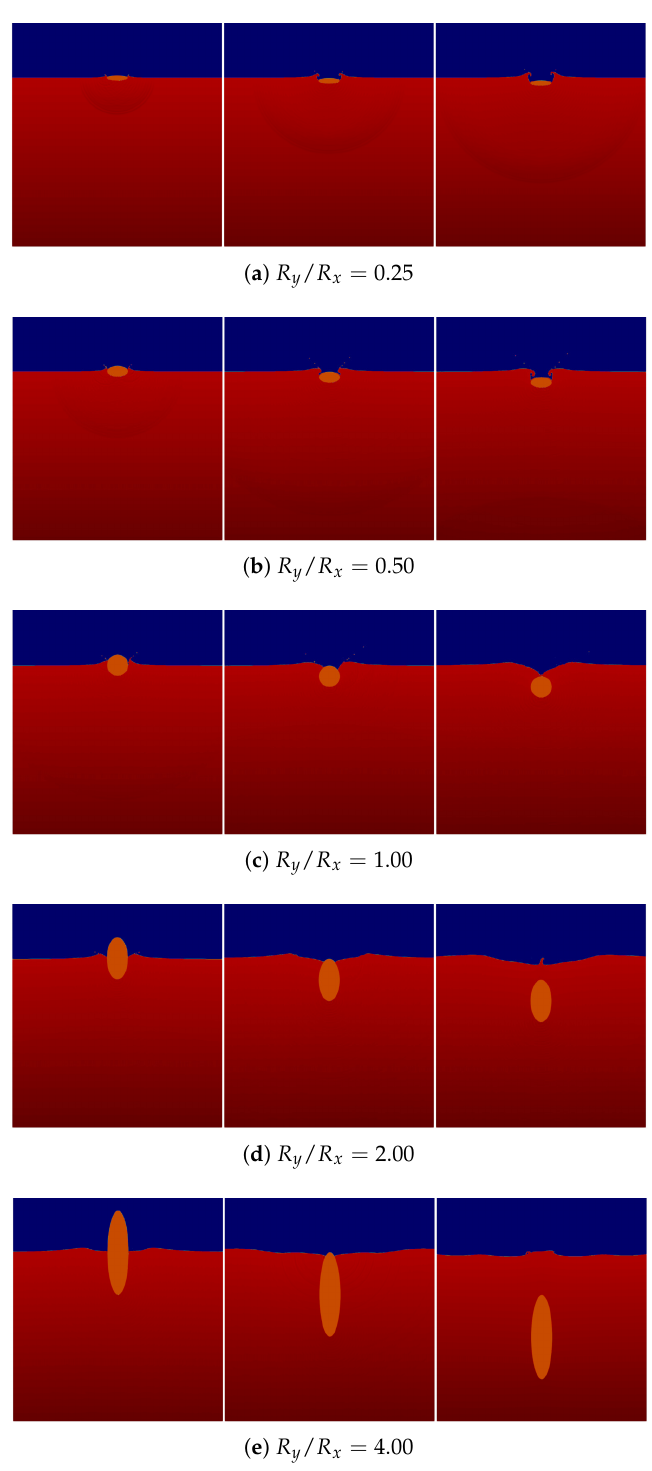
Figure 20. Density evolution at different non-dimensional times for different ellipse geometry. The three snapshots for ever radii ratio represent half of wedge wetted, full wetted wedge, and three-quarters of wetted wedge, respectively. The three obstacle penetrations correspond to the same non-dimensional times, more specifically t (cid:63) = 1.05, 2.10, and 3.10,